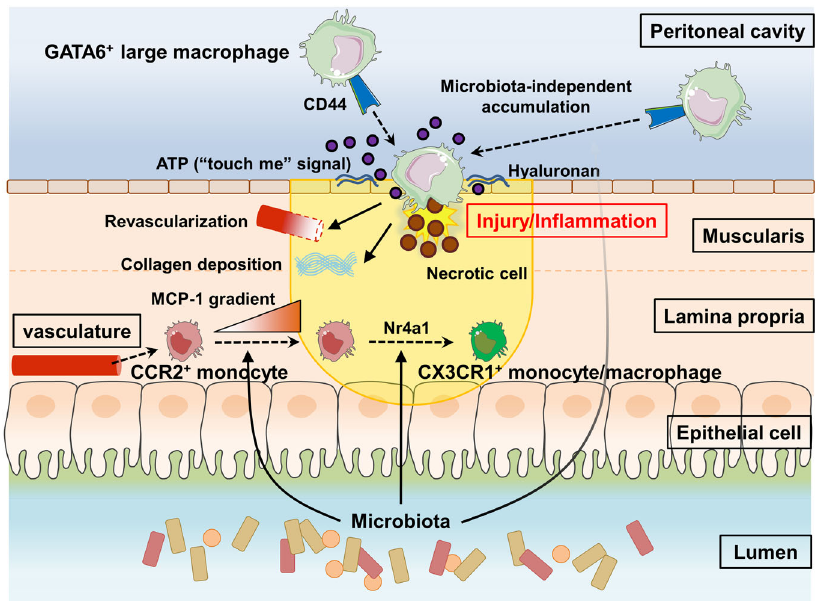
Fig. 8 GATA6 + peritoneal cavity macrophages in fi ltrate an injured intestine via a direct peritoneal route and contribute tissue repair. A scheme showing the mechanism of GATA6 + peritoneal macrophage recruitment and bloodstream-derived CCR2 + monocyte to CX3CR1 + monocyte/macrophage conversion in intestinal injury/in fl